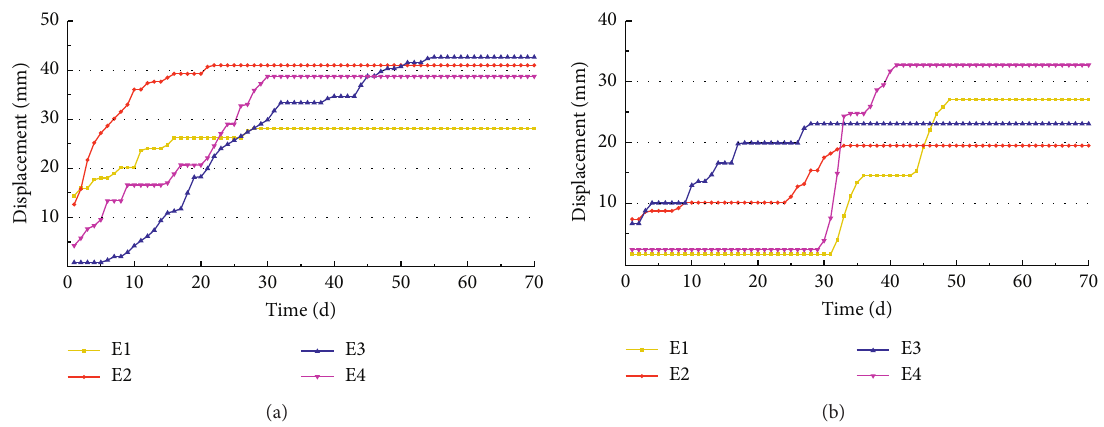
Figure 18: Monitoring results of displacement under combined support. (a) Displacement of both sidewalls. (b) Displacement of